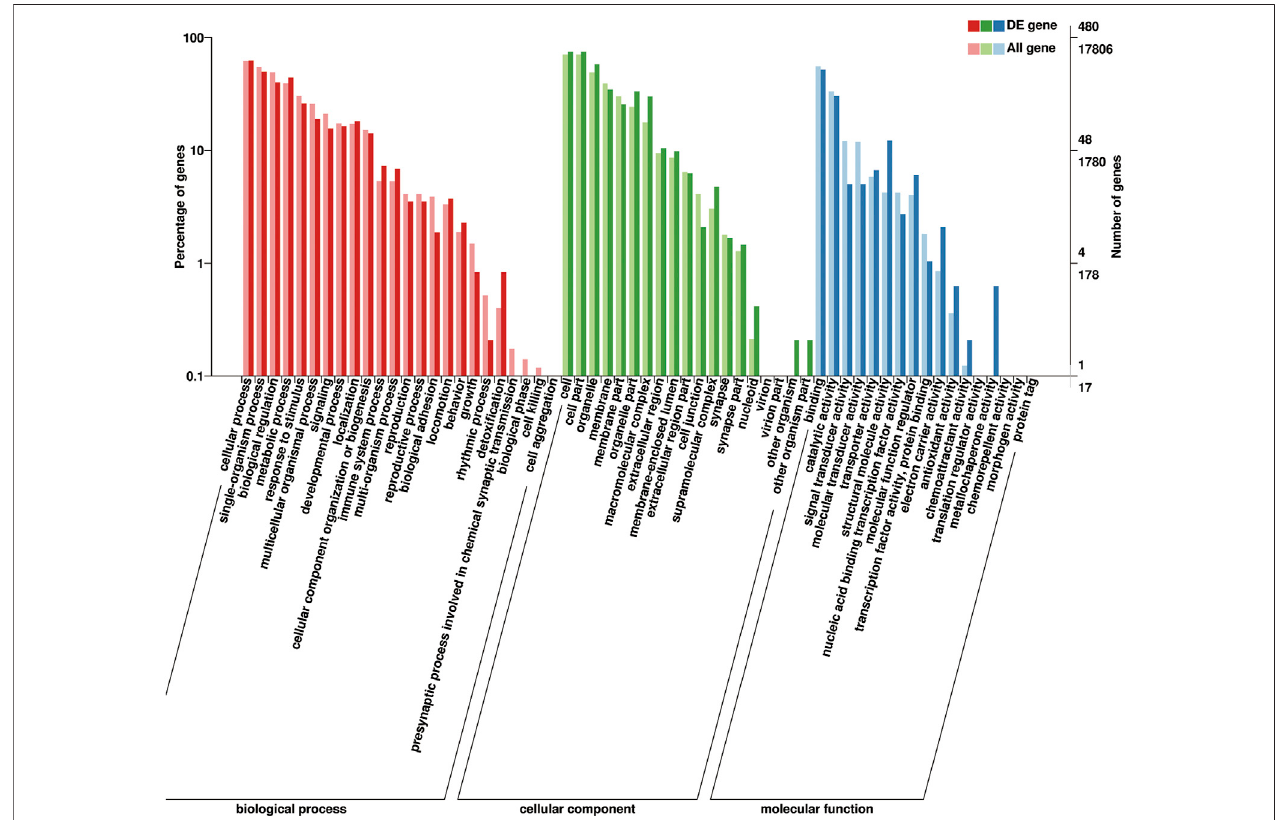
FIGURE 8 | Gene Ontology (GO) classi fi cation of 648 DEGs. GO terms are summarized in three main categories: cellular components, molecular functions, and biological processes.